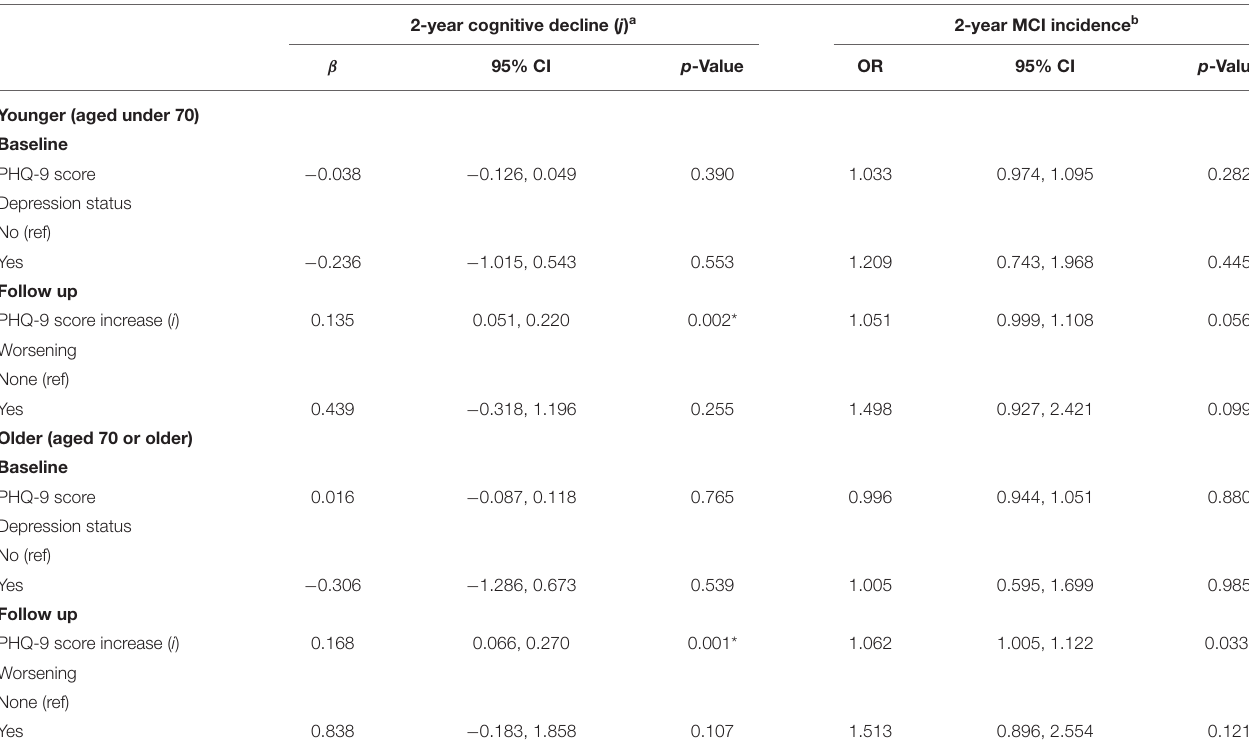
TABLE 4 | The associations between depression and cognitive function by age: Coefficients and 95% CIs for 2-year cognitive decline and Odds Ratios and 95% CIs for 2-year MCI